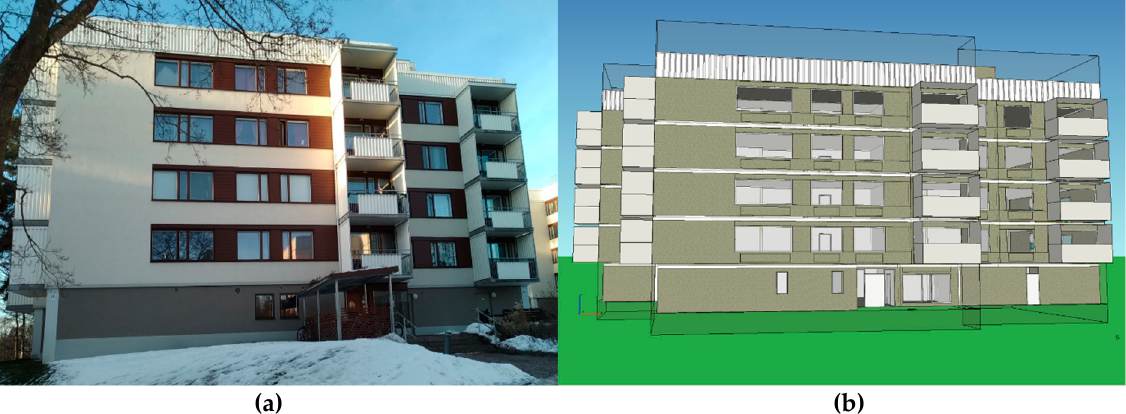
Figure 1. The simulated multifamily building, ( a ) real building (left), and ( b ) the IDA-ICE simulation model (right).